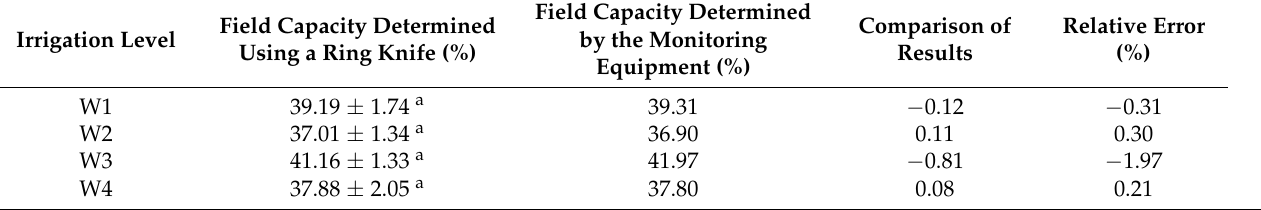
Table 3. The soil field capacity of each